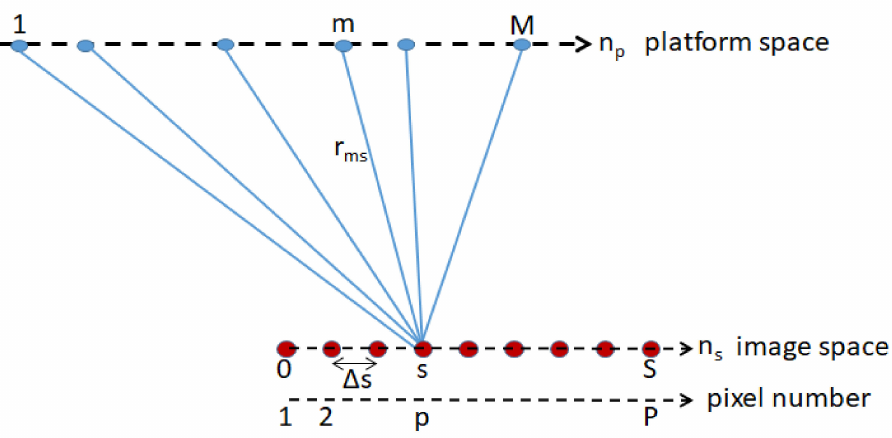
Figure 8. The geometry used in tomographic image generation. Blue and red circles represent platforms and image pixels, respectively, which are both distributed along n